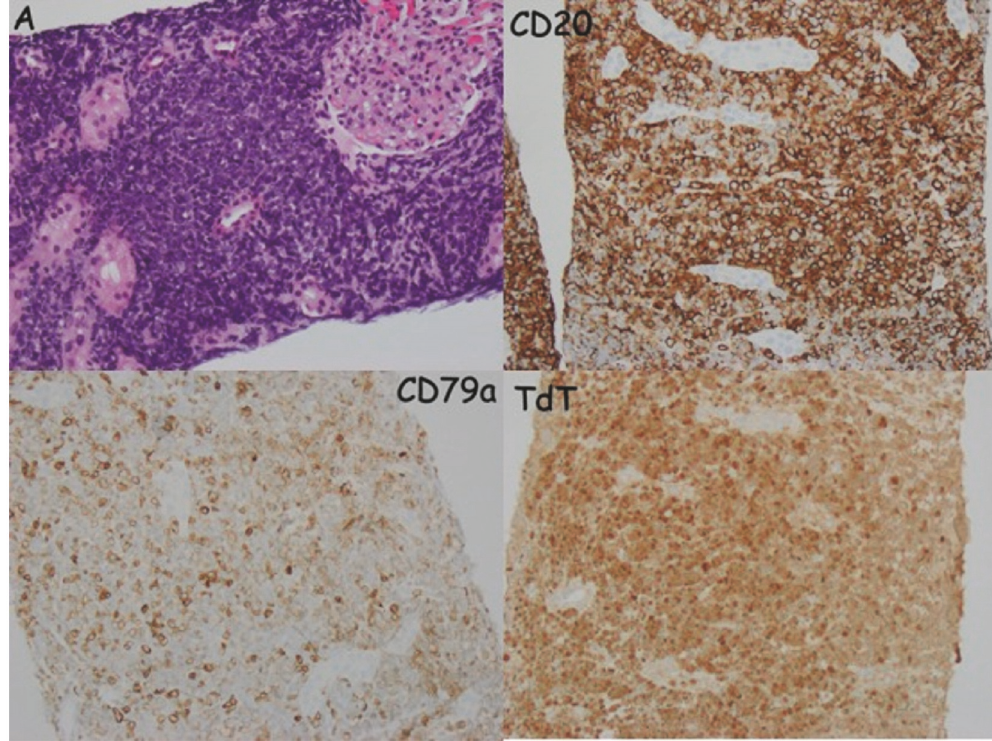
Figure 2: Fine needle aspiration of the kidney. Top left: H&E stain shows blue tumor cells infiltrating the kidney, pushing the tubules and glomeruli apart. Top right: CD20 marker positivity, which is associated with B-cells. Bottom left: CD79 marker positivity, which is associated with B-cells. Bottom right: Terminal deoxynucleotidyl transferase (TdT) positivity, often seen in acute lymphoblastic leukemia.